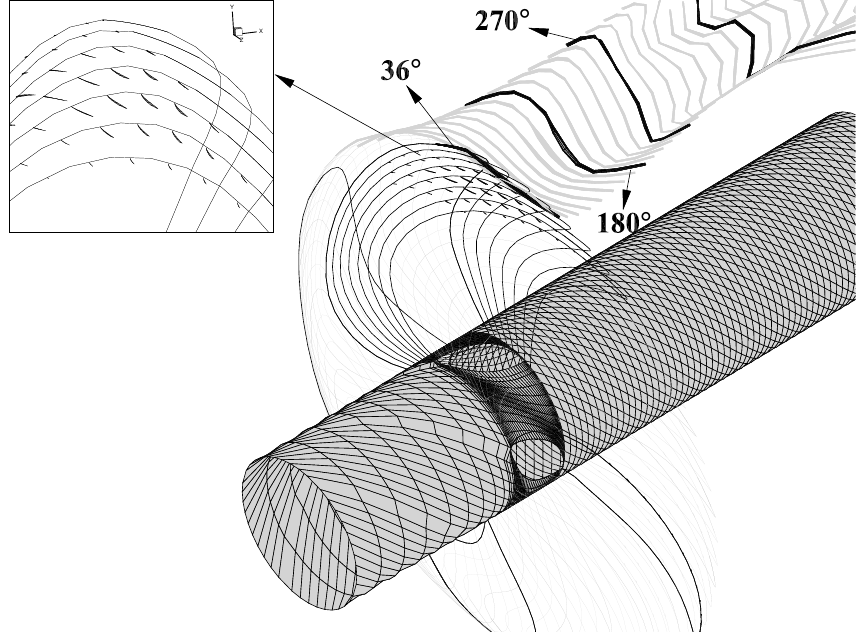
Figure 29. Developed tip vortex cavitation modeled by the BEM during one propeller revolution; SSPA P2772 propeller, σ n = 3.507, J S =